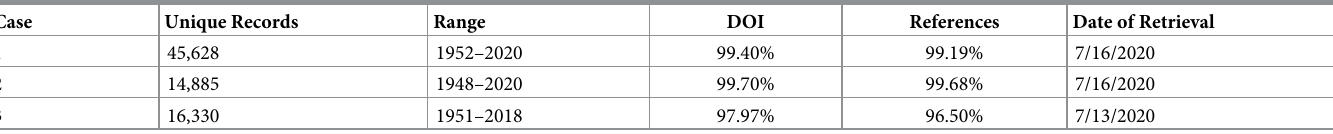
Table 2. Bibliographic profiles of datasets retrieved using CCE method for the selected Nobel Prize cases. Case Unique